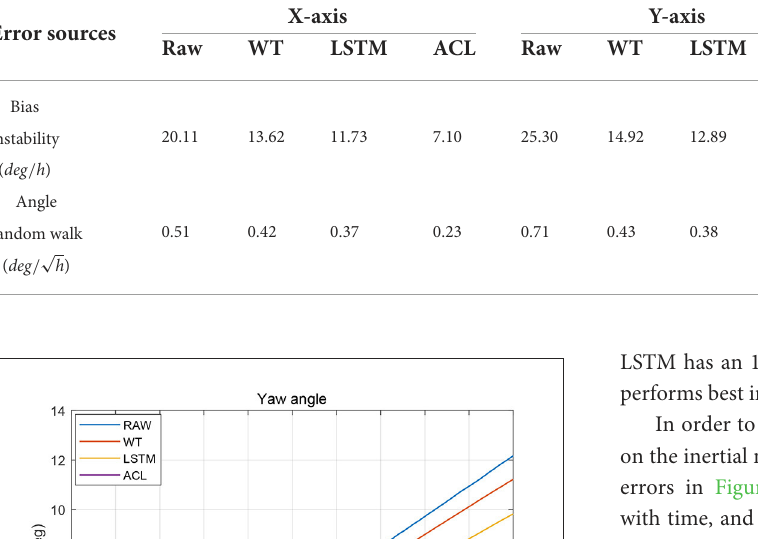
TABLE 4 Allan variance parameters of the XSENS MTI-G-700 3-axis gyroscope.